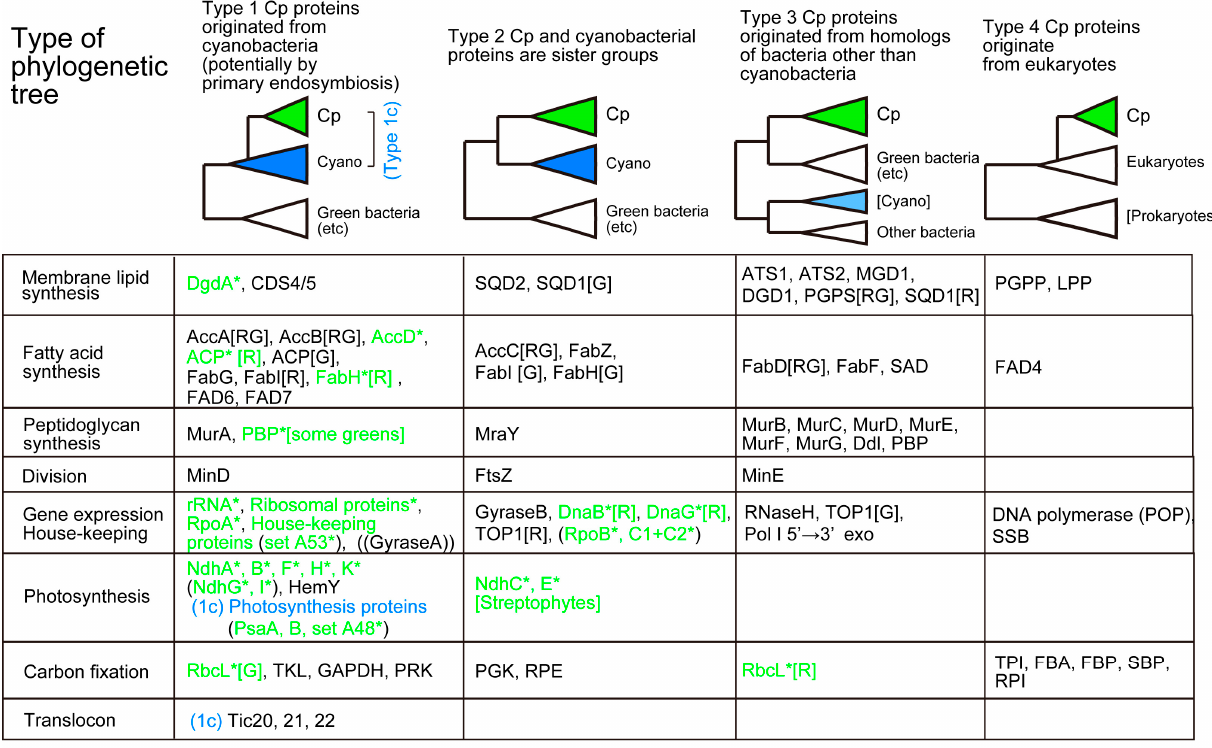
Figure 1. Four major types of phylogenetic relationships between cyanobacterial and chloroplast proteins. Chloroplast- encoded proteins (or RNA) are marked with an asterisk and colored. [R] and [G] indicate red and green lineages, respectively. This is an extended, revised version of the original in [9,50].